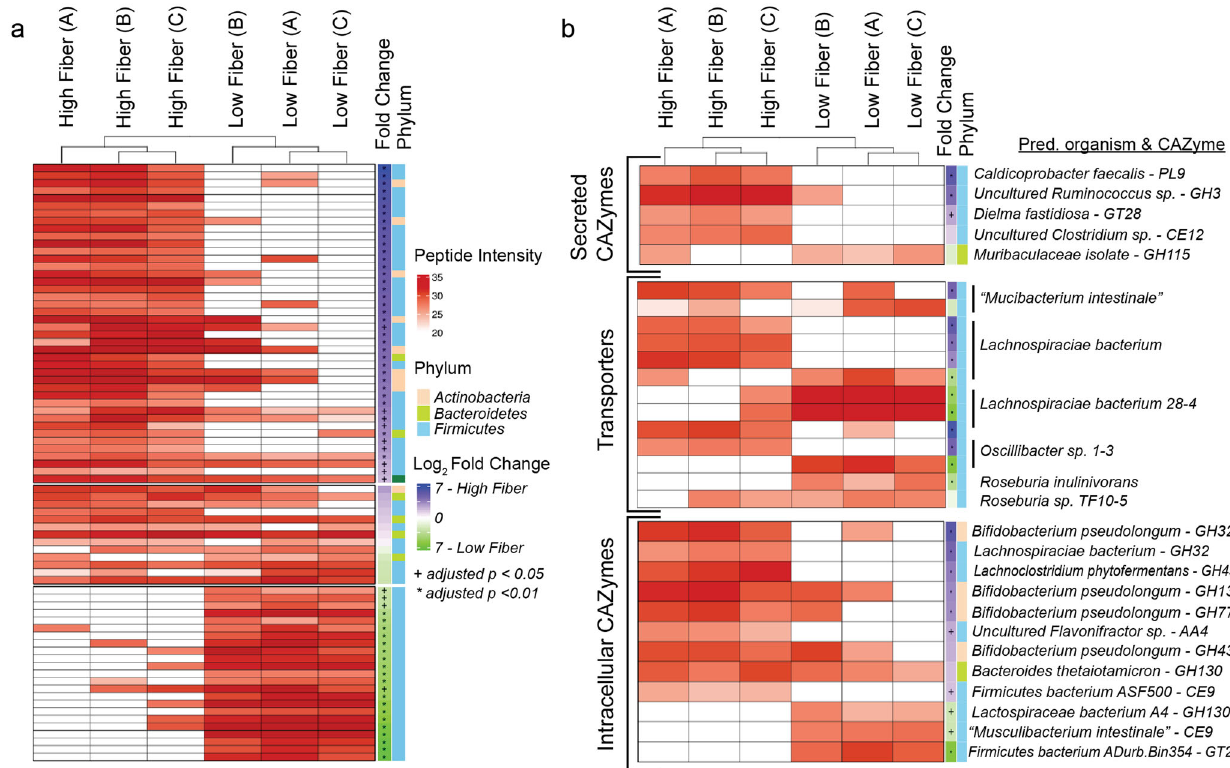
Fig. 2 Distinct enzymes revealed by ABPP as active in high and low fi ber conditions. Peptide intensities shown in red on the heatmap indicate the log 2 -transformed sum of unique peptide intensities for proteins that were targeted by the GH2c-ABP (rows) for each littermate sample group (columns). White cells indicate the protein was not detected in the speci fi ed littermate sample group. Littermate sample groups were clustered using Aitchison distance. A blue log 2 fold change indicates enrichment in HF conditions while green indicates proteins enriched under LF conditions (directly right of heat map; * q -value < 0.05; + q value < 0.01). The predicted phyla that produced the corresponding protein is shown in the rightmost column (Tan: Actinobacteria; light green: Bacteroidetes; light blue: Firmicutes). a The 78 carbohydrate-related proteins identi fi ed by ABPP. b A subset of the 78 carbohydrate-related proteins consisting of putative CAZymes and transporters.